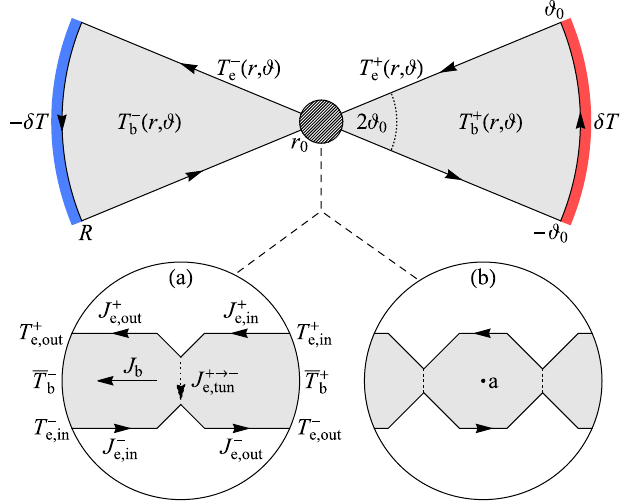
FIG. 2. Thermal transport within a phonon-coupled chiral spin liquid in the device geometry of Fig. 1. All temperatures shown here, including those of the hot and cold leads ( (cid:2) δ T ), are small relative temperatures with respect to an average overall temper- ature T 0 that corresponds to T in Fig. 1. There are distinct relative temperatures for the edge mode ( T ) and the bulk phonons ( T ). e b Each lobe is an annular section with opening angle 2 ϑ 0 , outer radius R , and inner radius r 0 . The central channel carries a bulk ¯ T (cid:2) heat current J driven by the different mean bulk temperatures b b at its two ends, as well as chiral edge heat currents J (cid:2) determined e . For each edge, the tunneling by the local edge temperatures T (cid:2) e heat current J þ → − associated with the pinch point(s) changes the e; tun ∓ J þ → − J (cid:2) edge heat current from J (cid:2) to J (cid:2) . While these e; tun e; out ¼ e; in e; in notations are shown for the single-pinch case (a), they readily generalize to the double-pinch case (b), where the tunneling heat current J þ → − has contributions from both pinch points and is e; tun sensitive to bulk anyons “ a ” in between